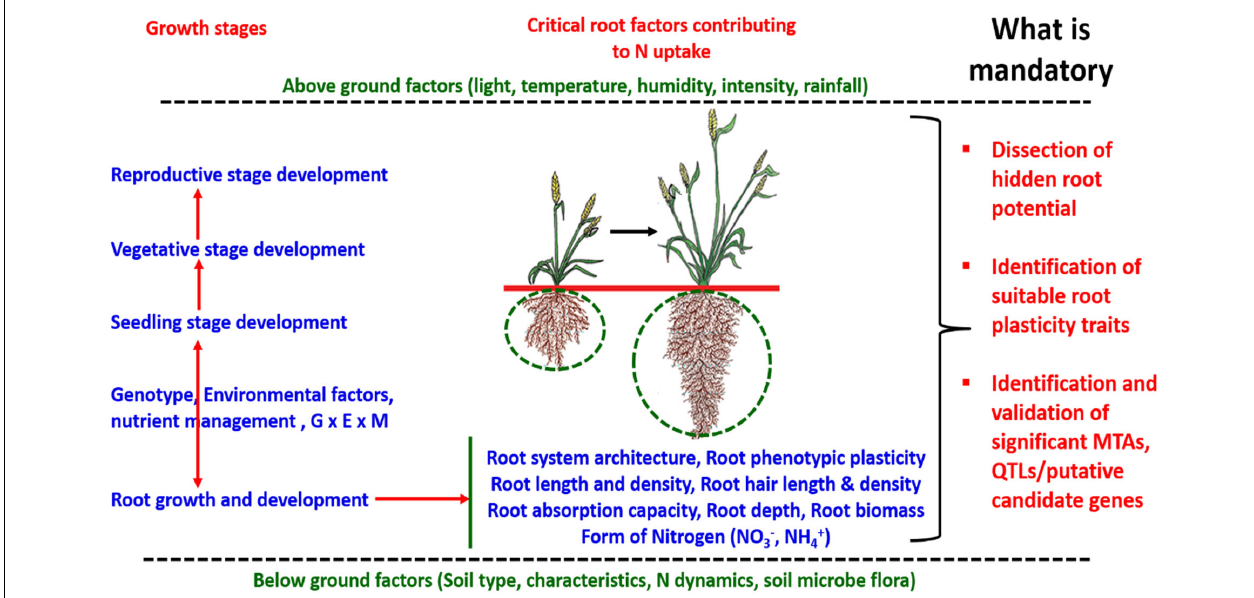
FIGURE 4 | The schematic representation of the role of above and below ground factors, genotype-environment-nutrient interactions playing significant roles in developing root architecture at different stages of growth and development for efficient nitrogen uptake in cereal